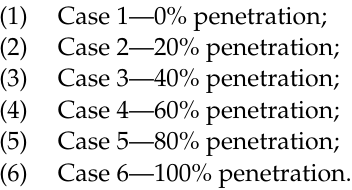
Z relay location representation. Figure 2. IEEE 33 node model along with Solar PV-DGs and Z fcl fcl relay location representation.